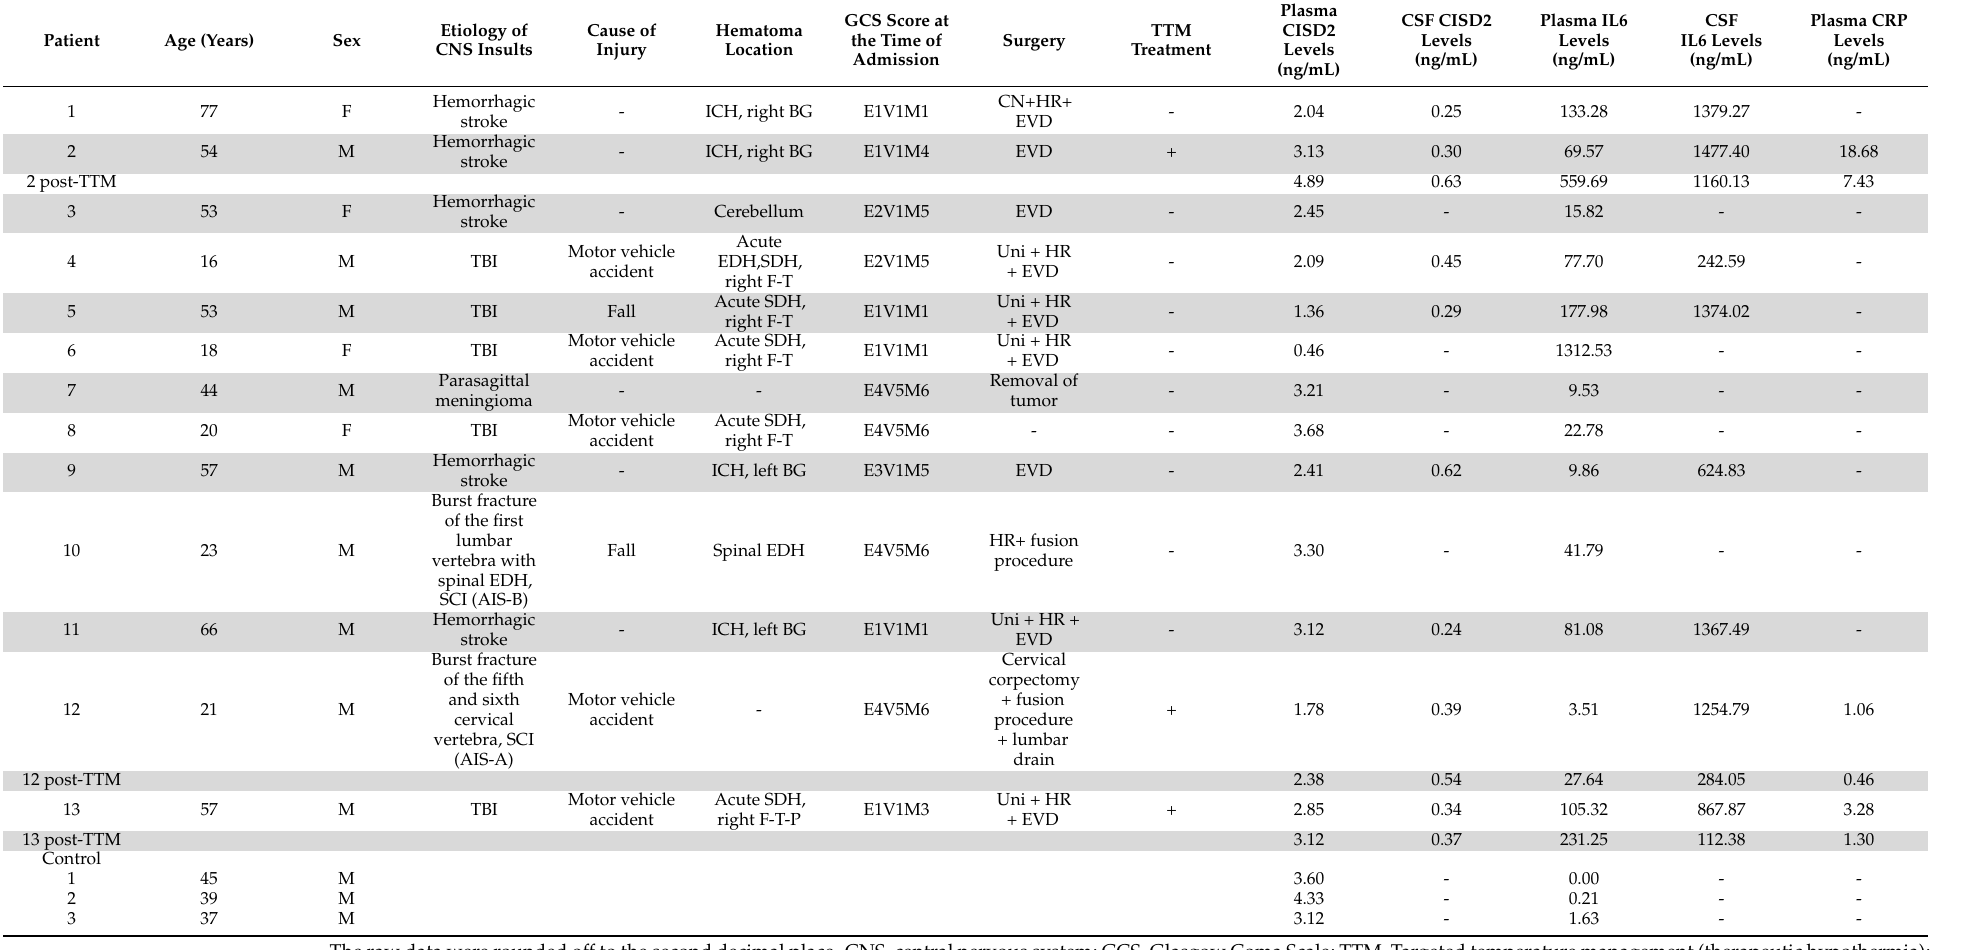
The raw data were rounded off to the second decimal place. CNS, central nervous system; GCS, Glasgow Coma Scale; TTM, Targeted temperature management (therapeutic hypothermia); CRP, C-reactive protein; M, male; F, female; TBI, traumatic brain injury; SCI, spinal cord injury; EDH, epidural hematoma; SDH, subdural hematoma; ICH, intracerebral hematoma; BG, basal ganglion; F, frontal; T, temporal; P, parietal; Uni + HR, unilateral craniectomy + removal of hematoma; CN, craniotomy; EVD, external ventricular drain; AIS, American Spinal Injury Association Impairment